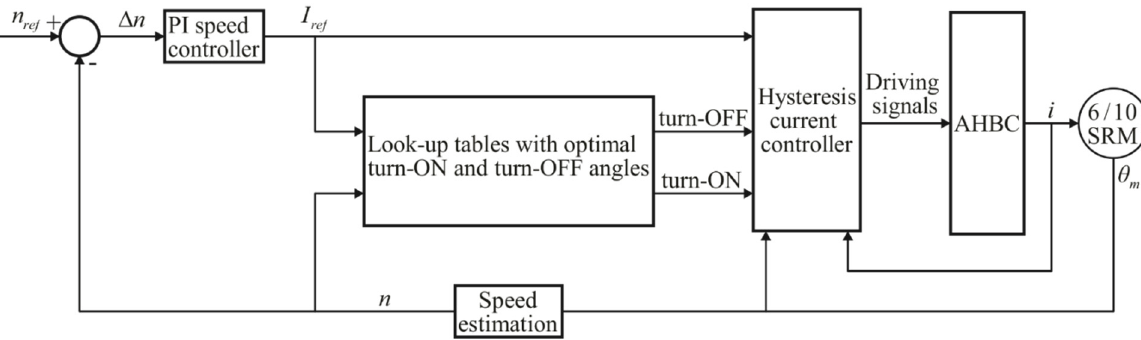
Figure 32. SRM control scheme.